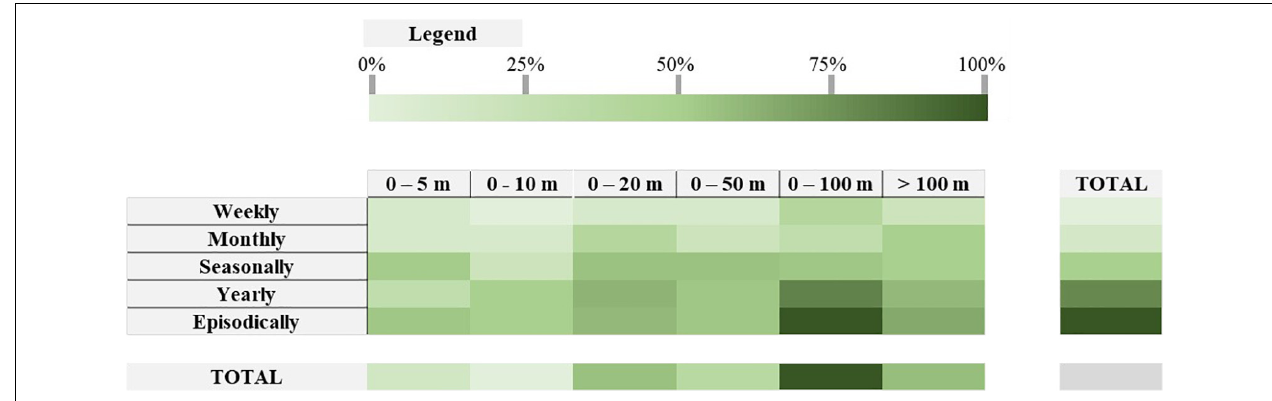
FIGURE 12 | Heatmap of user requirements in depth range and temporal update of potential bathymetry products. The shading indicates the percentage of the 176 respondents who selected the box (legend at the top).